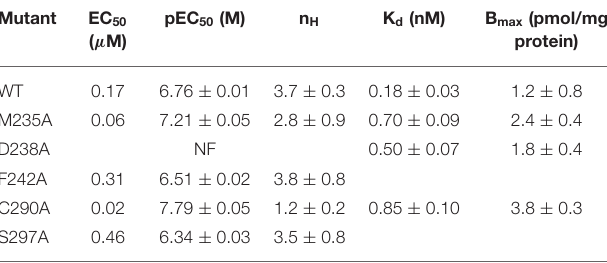
TABLE 1 | Mutant receptors in HEK293